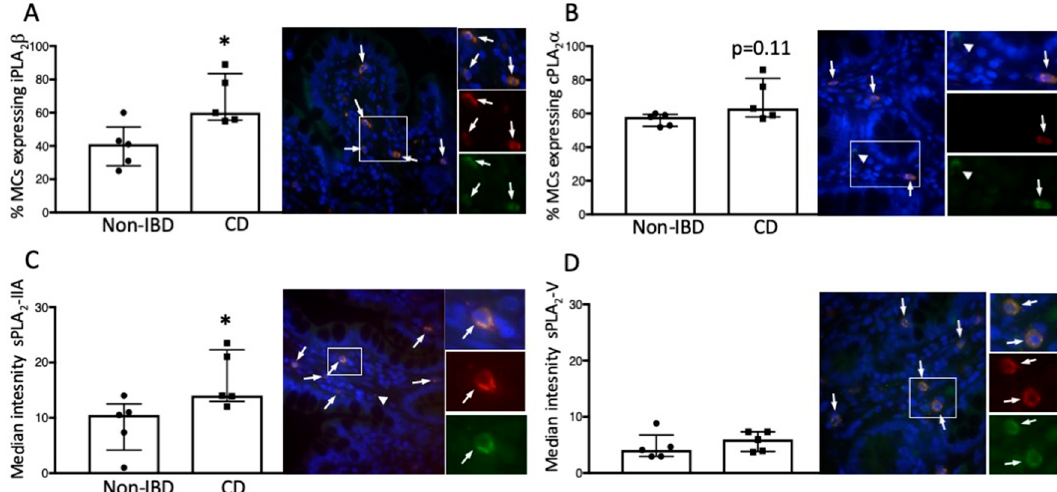
Figure 7. Expression of iPLA 2 β , cPLA 2 α , sPLA 2 -IIA and sPLA 2 -V on mast cells (MCs) in the intestinal mucosa of 5 patients with Crohn’s disease (CD) and 5 controls. ( A ) Percentage of MCs expressing iPLA 2 β . Arrows indicate MCs co-localizing with iPLA 2 β in a patient with CD. ( B ) Percentage of MCs expressing cPLA 2 α . Arrows indicate MCs co-localizing with cPLA 2 α in a control patient. Arrow-head indicates cPLA 2 α expression in a cell not positive for MC tryptase. ( C ) Expression intensity of sPLA 2 -IIA on MCs. Arrows indicate MCs co-localizing with sPLA 2 -IIA in a patient with CD. Arrow-head indicates sPLA 2 -IIA expression in a cell not positive for MC tryptase. ( D ) Expression intensity of sPLA 2 -V on MCs. Arrows indicate MCs co-localizing with sPLA 2 -V in a control patient. MC and PLA 2 expressions were quantified manually at 600× magnification and results are given as median (25th–75th percentile). Red = MCs, Green = PLA 2 , Blue = DAPI, nuclei staining. * p < 0.05 vs. controls.